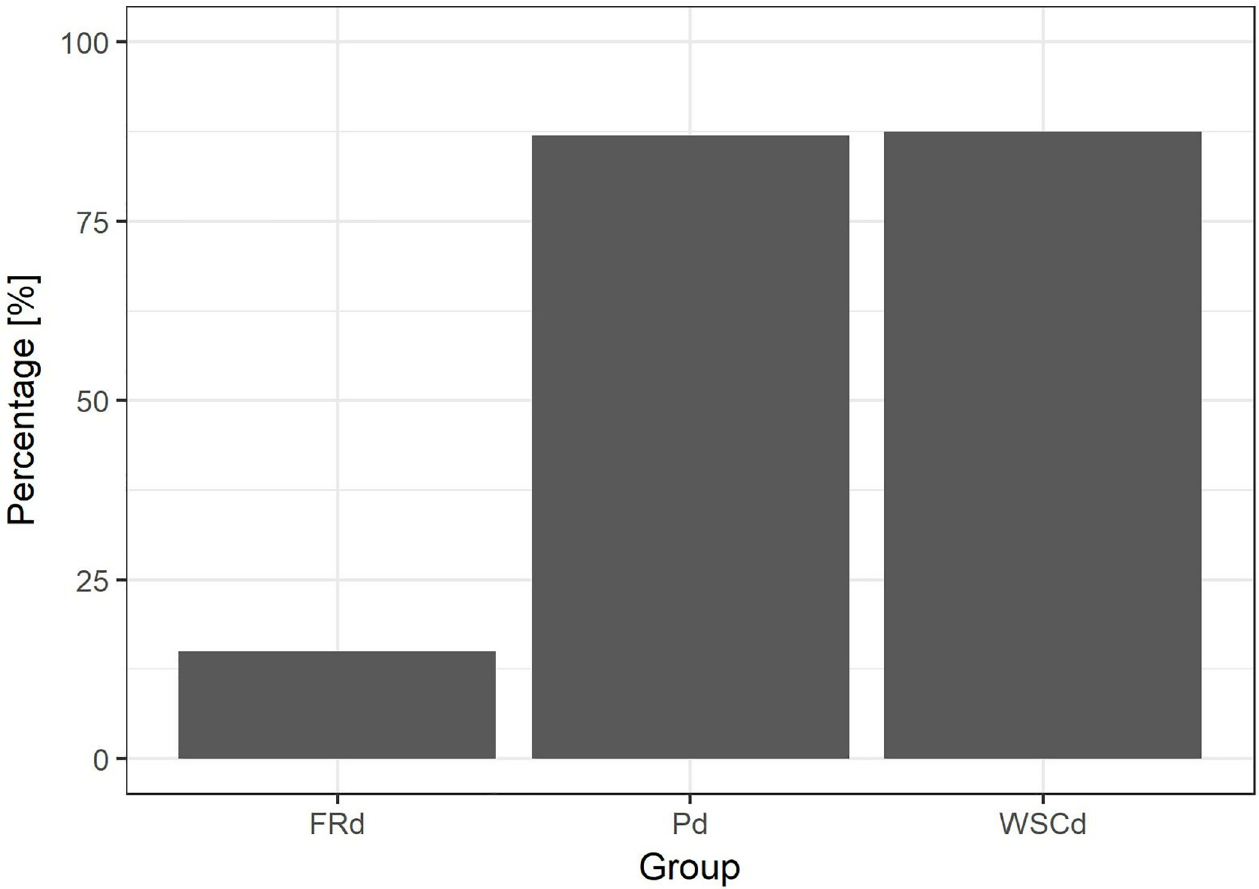
Fig 4. Manipulation of the ball. Proportion of individuals that manipulated the ball in the three groups (Pd: pet dogs, FRd: free-ranging dogs, WSCd: WSC dogs).